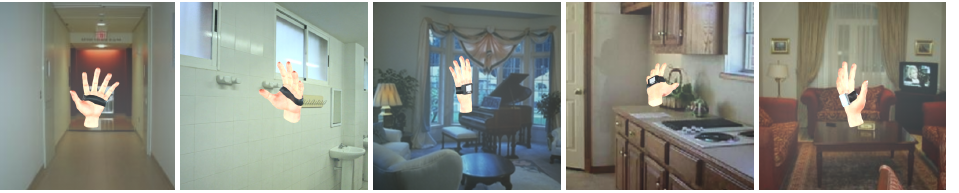
Figure 6. Examples of APDM-Hand images from different views and backgrounds. Table 2. Comparison between different synthetic